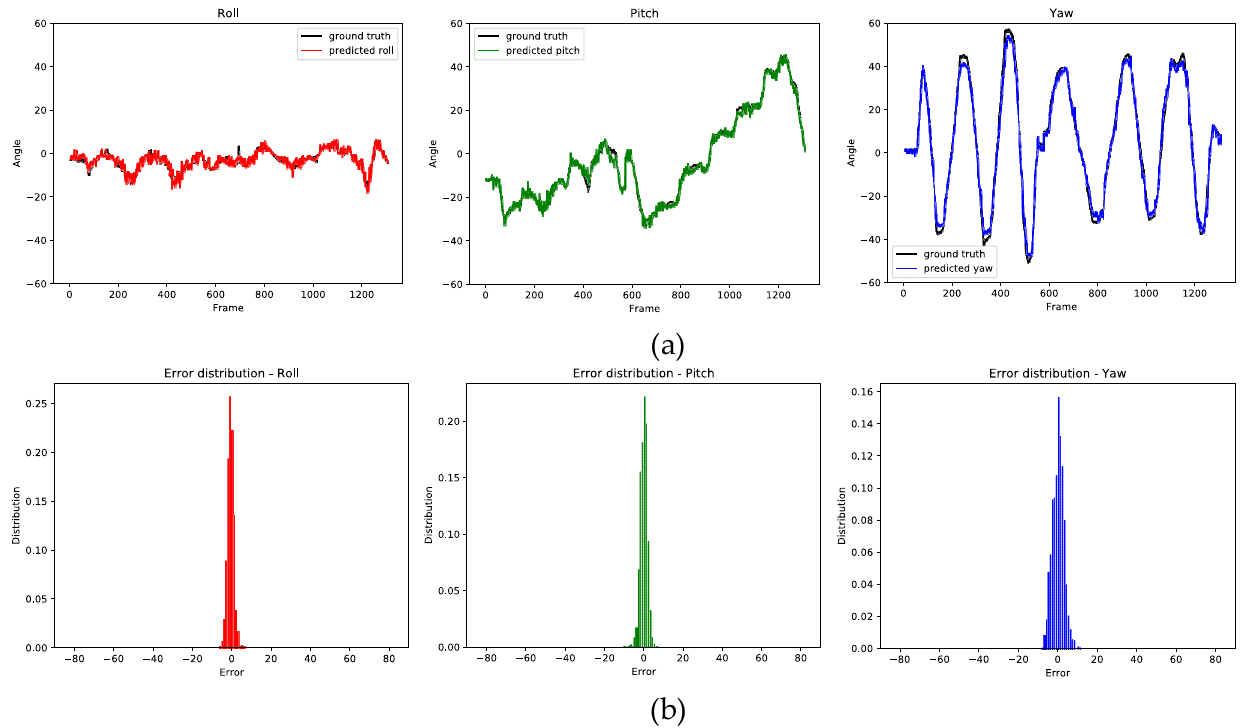
Figure 9. Results of the Biwi dataset: ( a ) reports the comparison between the ground truth and the predicted value for each frame (ground truth is the black line). ( b ) reports the error distributions for each angle.